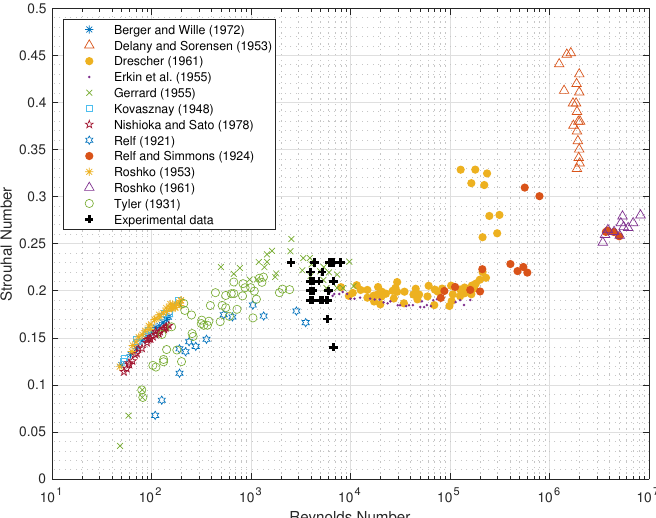
Figure 8. Strouhal number–Reynolds number relationship for circular cylinders taken from [5], the black crosses represent our experimental